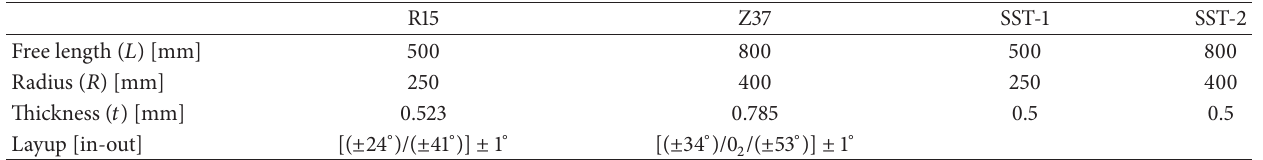
Table 1: Geometric parameters for tested